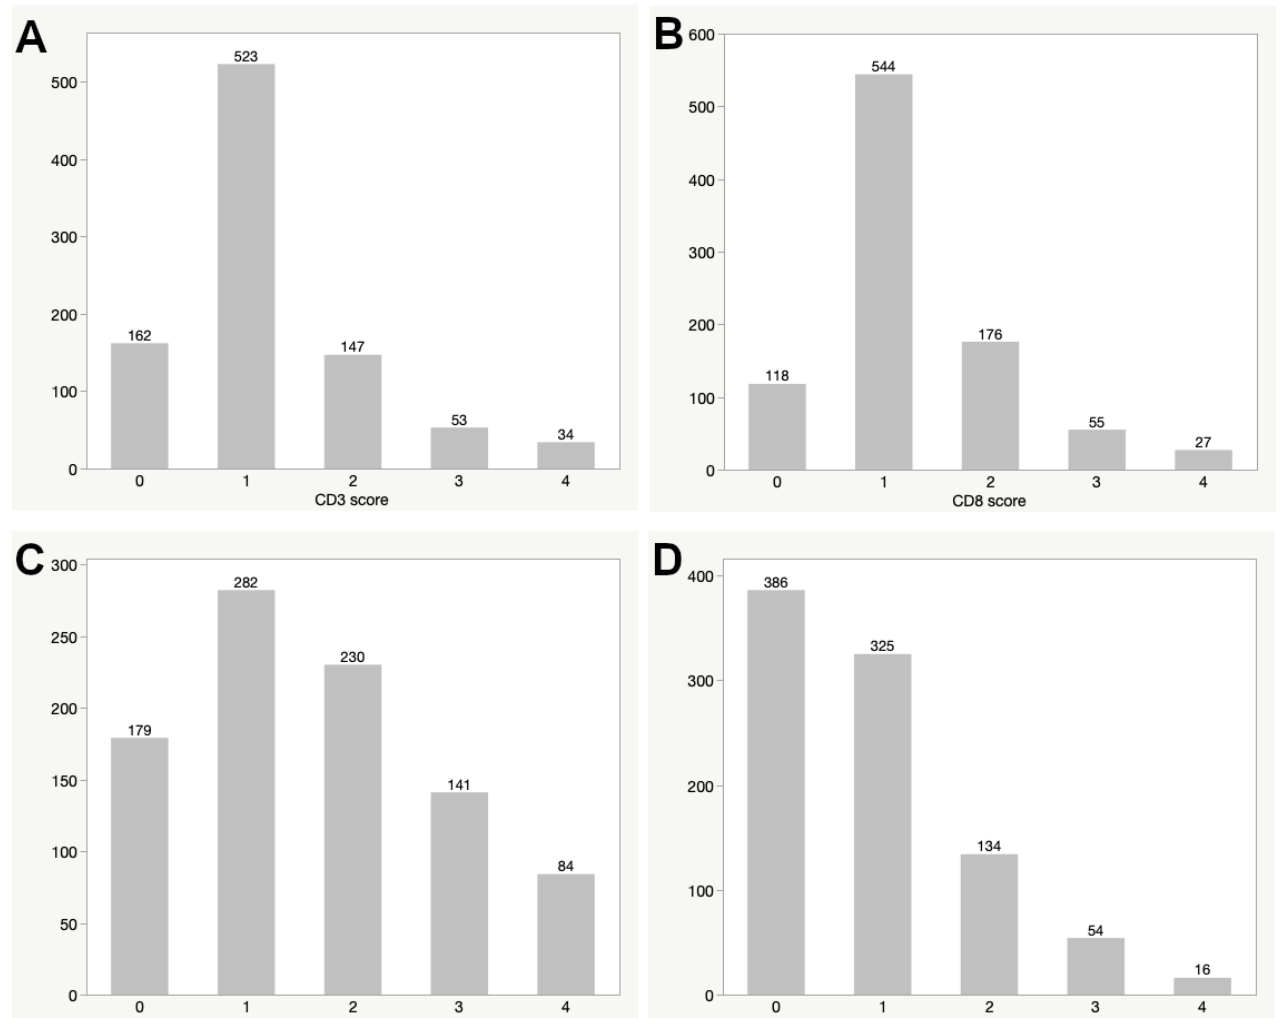
Figure 1. Distribution of the immunohistochemical expression score for CD3 ( A ), CD8 ( B ), CD68 ( C ) and CD163 ( D ).